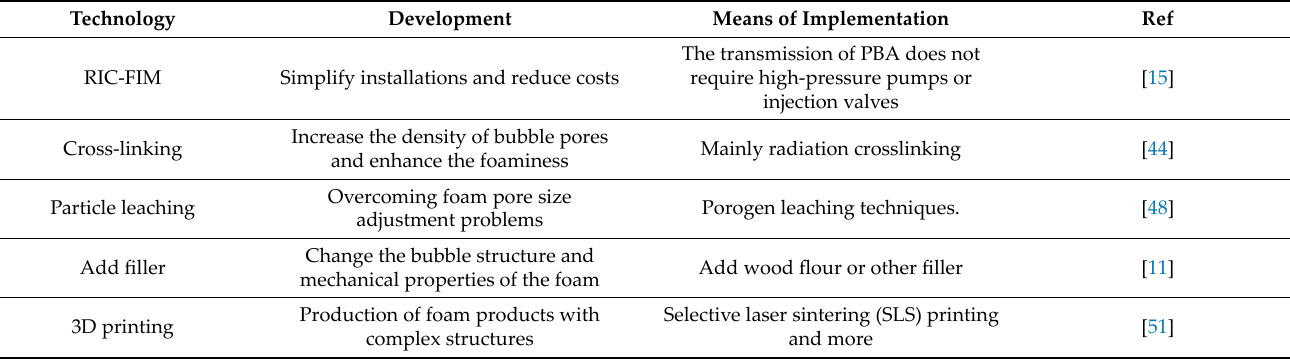
Table 1. List of favorable technologies and